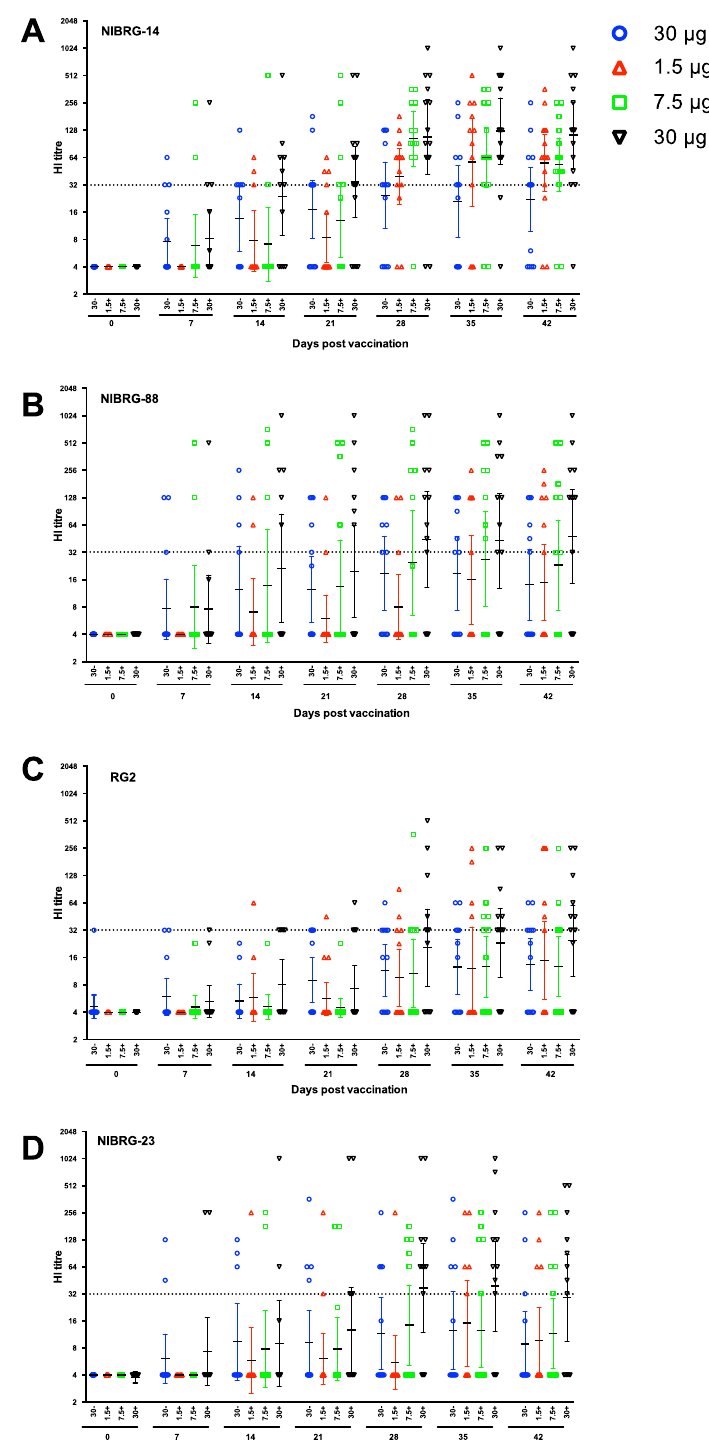
Fig 4. The kinetics of the haemagglutination inhibition antibody response induced after vaccination. The kinetics of the haemagglutination inhibition (HI) antibody response to the homologous vaccine strain (A) A/Vietnam/1194/2004 (NIBRG-14) and the cross-H5 clade HI responses to (B) A/Cambodia/R0405050/2007 (NIBRG-88), (C) A/Indonesia/5/2005 (RG2) and (D) A/turkey/Turkey/1/2005 (NIBRG-23) strains were measured by the HI assay. Subjects were vaccinated with two doses (21 ± 1 days apart) of